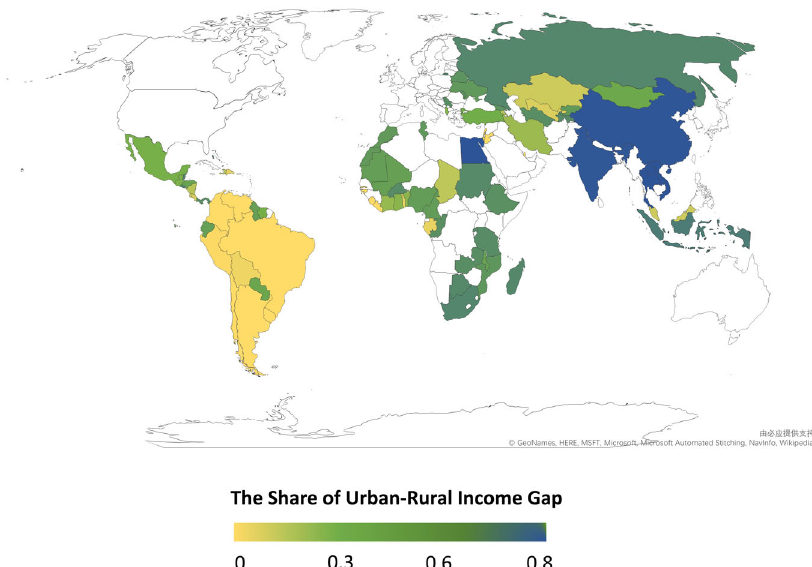
Fig. 3 Contribution of urban-rural gap to national inequality in developing economies. This shows the share of the urban-rural gap in national income inequality in the latest year. Notes: (1) Developed countries are urbanized and thus are not included. (2) National income inequality (the Theil-L index) is converted from the Gini ratios in the Standardized World Income Inequality Database (SWIID v7.1). (3) The urban-rural income gap is estimated by the authors (see methods in the appendix).